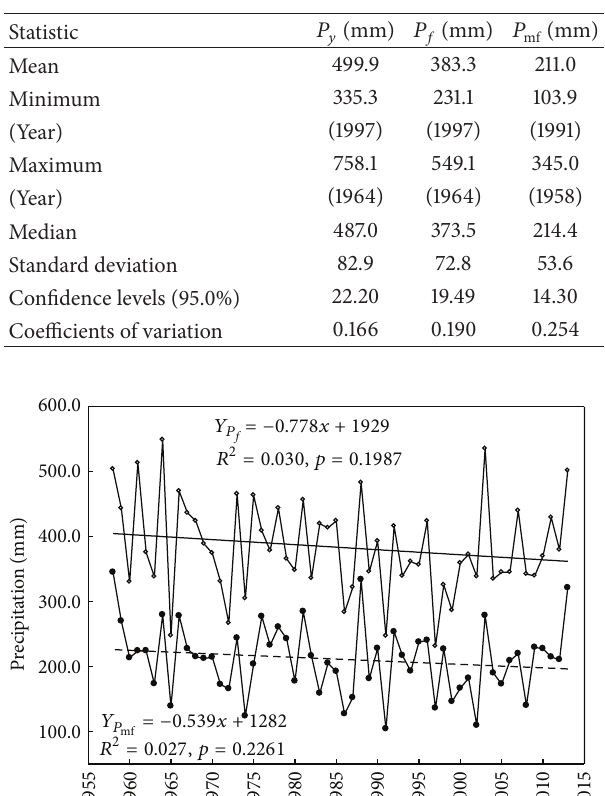
Table 2: Statistics for annual precipitation ( 𝑃 𝑦 ), precipitation of flood season ( 𝑃 𝑓 ), and precipitation of main flood season ( 𝑃 mf ) of the Middle Yellow River from 1958 to 2013.